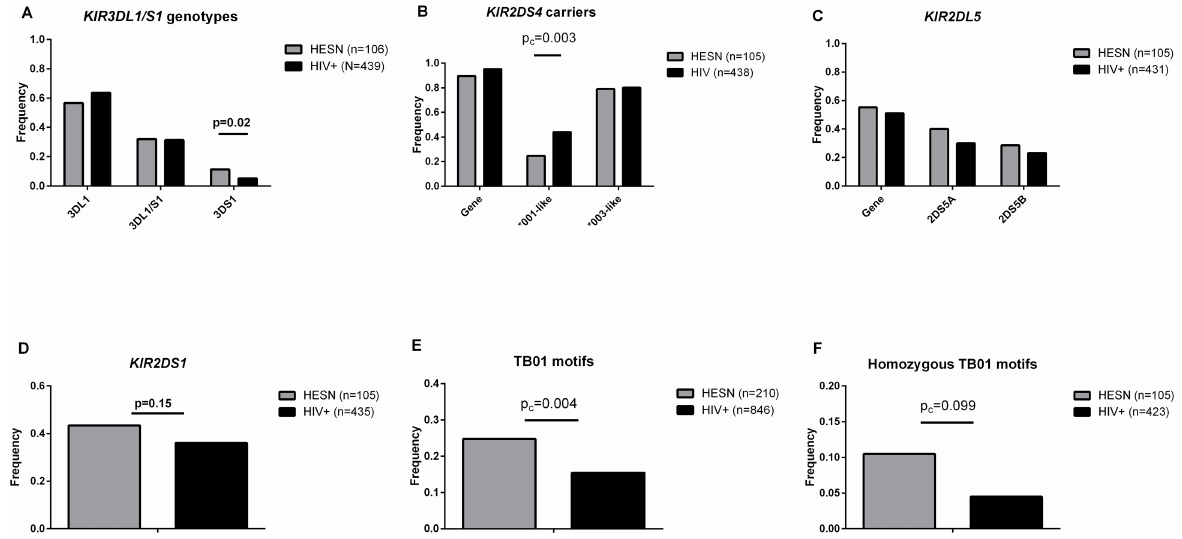
Fig 2. Killer Immunoglobulin-like Receptor (KIR) generic genotype and allele group frequencies in HIV exposed seronegative (HESN) and recently infected HIV positive (HIV+) subjects. Shownon the y-axis is the frequency of (A) HESN (n = 106) and HIV+ (n = 439) subjectspositive for the three KIR3DL1/S1 generic genotypes, (B) HESN (n = 105) and HIV+ (n = 438) subjectspositive for a KIR2DS4 gene and carryingat least 1 copy of a KIR2DS4 * 001- likeor KIR2DS4 * 003- like allele(C) KIR2DS4 * 001- likeor KIR2DS4 * 003- like allelegroups amongthe 210 and 876 KIR haplotypes from HESN (n = 105) and HIV+ (n = 438) subjects, (D) HESN (n = 105) and HIV+ (n = 431) subjects positive for a KIR2DL5 , KIR2DL5A and KIR2DL5B gene, (E) HESN (n = 105) and HIV+ (n = 435) positive for a KIR2DS1 gene, (F) TB01 motifs among the 210 and 846 KIR haplotypes from HESN (n = 105) and HIV+ (n = 423) subjects and (G) HESN (n = 105) and HIV+ (n = 423) subjects positive for a homozygous TB01 motif. P’-valuesover the lines linkinggroups being comparedare corrected for